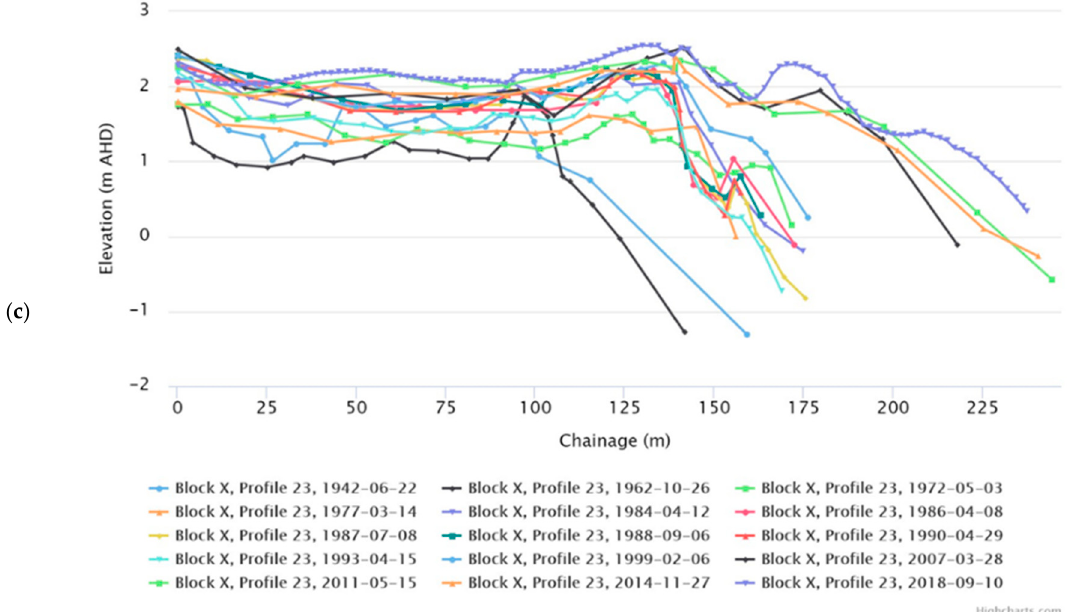
Figure 8. Historic beach profile for ( a ) Maloney’s Beach Block E Profile 8 from 1942-06-22 to 2018-09-10; ( b ) Cullendulla Beach Block Y Profile 1 from 1942 to 2018; and ( c ) Corrigans Beach Block X Profile 23 from 1942 to 2018 (Source: http://www.nswbpd.wrl.unsw.edu.au/photogrammetry/nsw/ Accessed 12 February 2020).